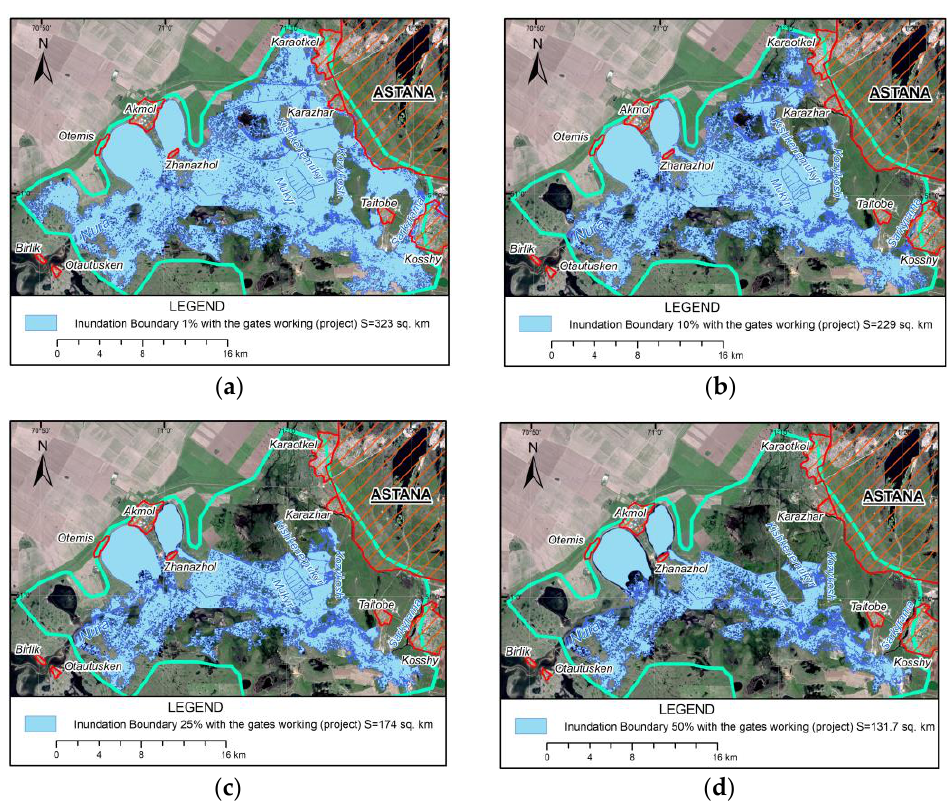
Figure 13. Inundation areas during simulation of different hydrographs using the modified DEM: